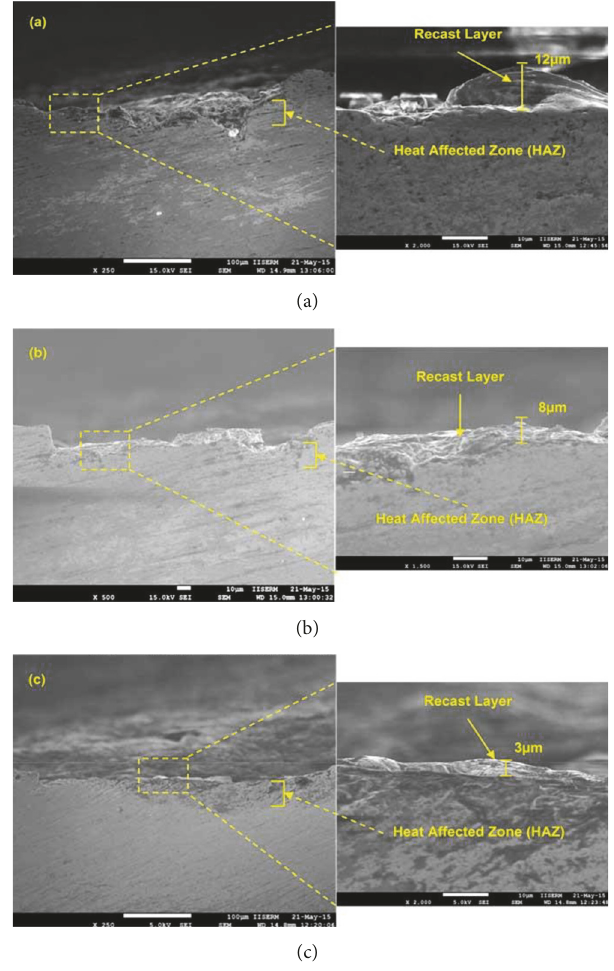
Figure 18: It shows a microscopic cross section of AM-EDMed 𝛽 - phase Ti-alloy at Ip (5A), Ton (10 𝜇 s), and Si-powder concentration of (a) 0 g/L, (b) 2g/L, and (c) 4 g/L [11].